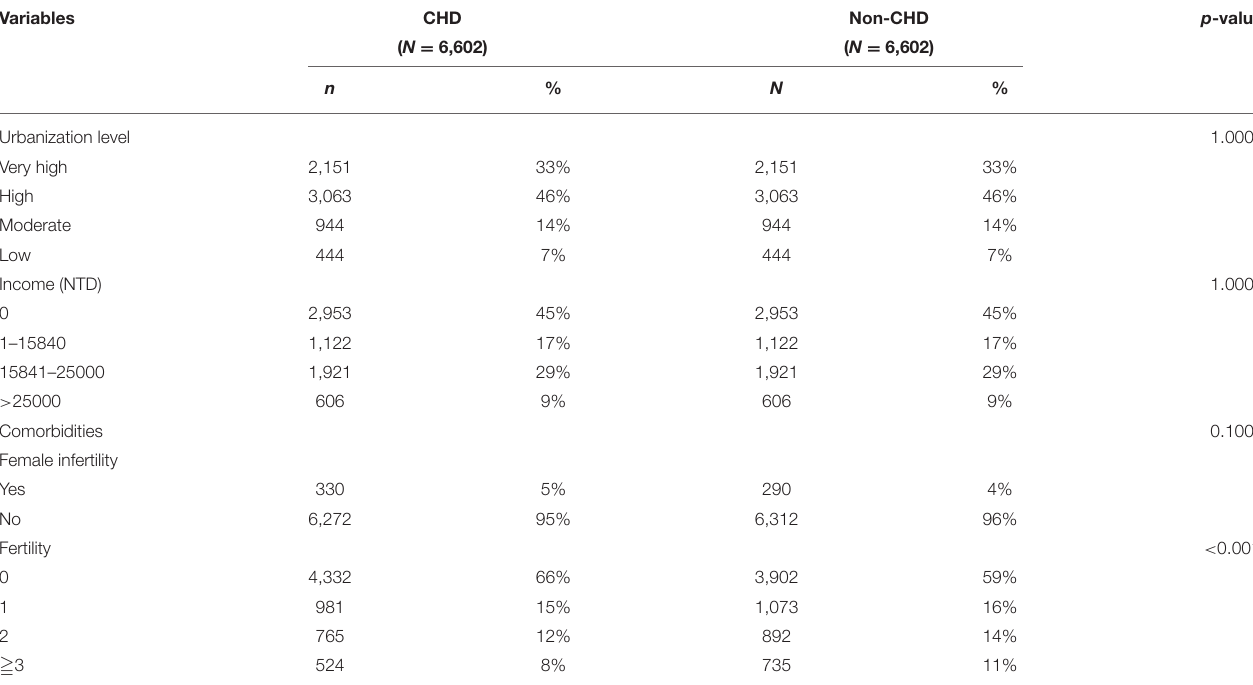
TABLE 1 | Characteristics of the study subjects. Variables